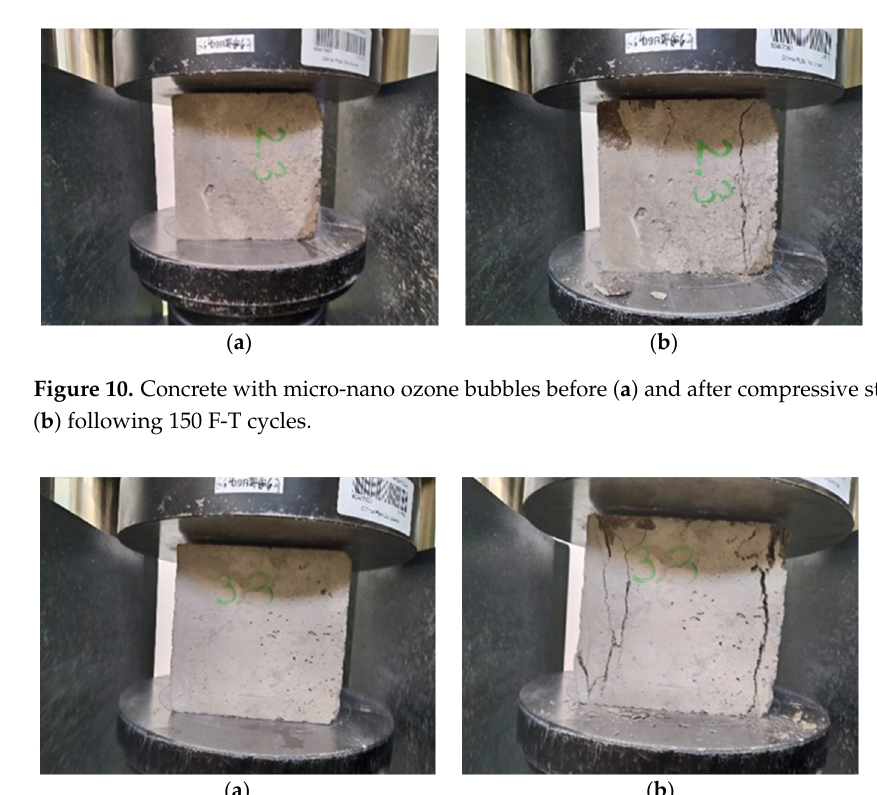
Figure 9. Concrete with micro-nano oxygen bubbles before ( a ) and after compressive strength testing ( b ) following 150 F-T cycles.